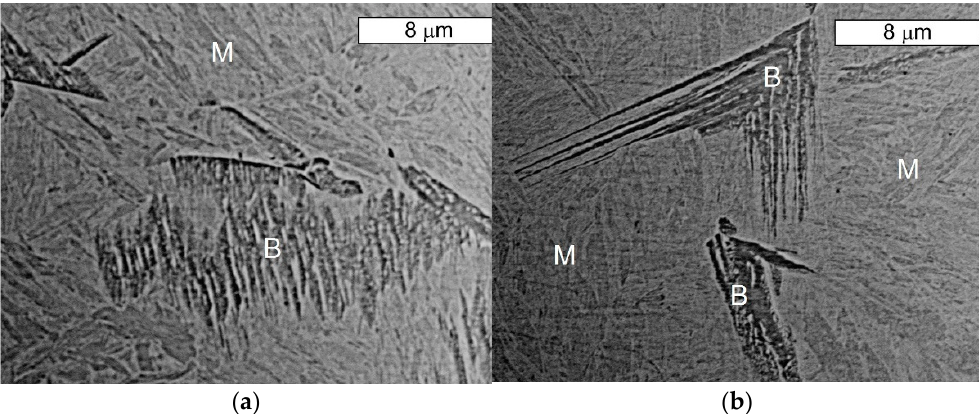
Figure 8. Microstructure of the Hardox steel obtained from sample 1: ( a ) visible bainite (B) with features typical for lower bainite on the tempered martensite matrix (M); ( b ) visible bainite (B) with features typical for upper bainite on the tempered martensite matrix (M). SEM, etched state.